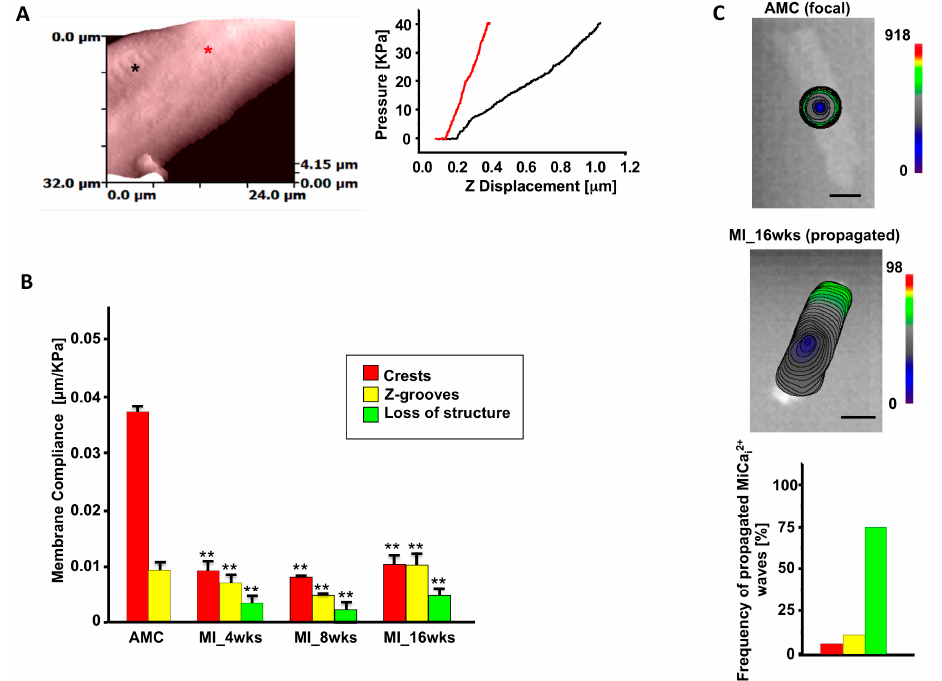
Figure 3. Membrane compliance related to mechanically induced Ca 2+ release. ( A ) Left. SICM topographical image of a failing rat ventricular cardiomyocyte. Asterisks indicate the position where hydrojet pressures were applied (black = partially striated area, red = unstriated area). Right. Pressure vs. Z displacement in the two positions selected on SICM image. To note the unstriated area is stiffer; ( B ) Membrane compliance ( µ m/kPa) during progression toward HF (MI-16 weeks (wks)) in crest, groove, and unstriated areas; ( C ) Mechanically-induced Ca 2+ release after hydrojet pressure delivery, in AMC cell top and in HF cell bottom. * p < 0.05 vs. control; ** p < 0.001 vs. control. Modified from [6] with permission.